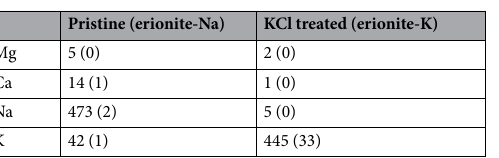
Table 2. ICP-OES analyses of the supernatant for cation release (calculated as nmol/mg sample). Data of pristine sample taken from ref. 16. Data report the net cation release obtained by subtracting the cation release obtained at the same pH (ca. 5) in H 2